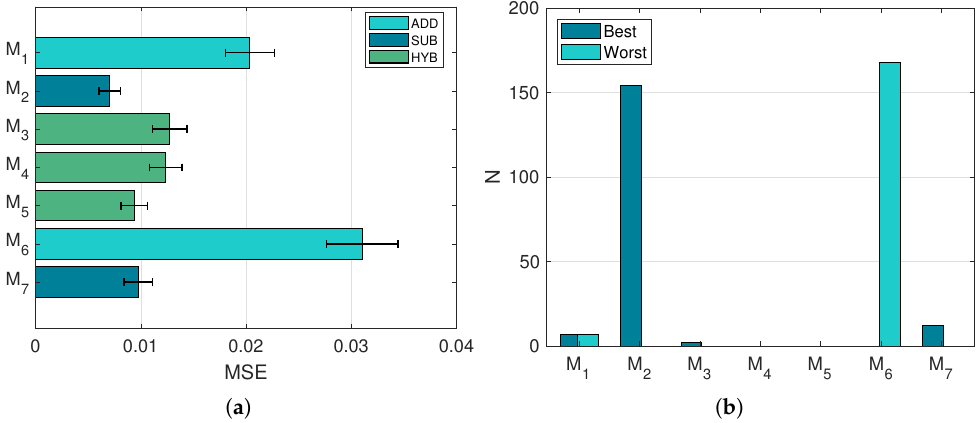
Figure 6. Performances in the model expectation test. ( a ): Average MSE values and respective 95% confidence intervals. ( b ): Number of times each model has been selected as best or worst in terms of